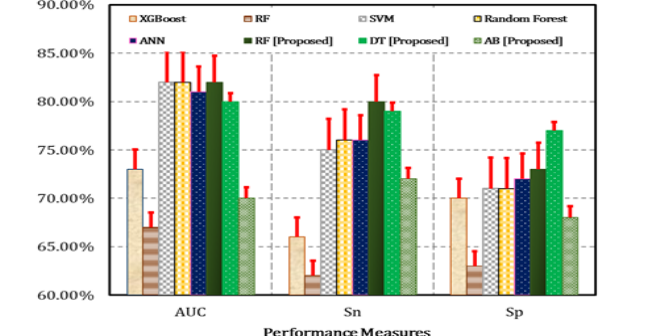
Figure 7. Comparison of the proposed approach with the state of the art [37,69–72]. Table 4. Comparison between the proposed and existing models.